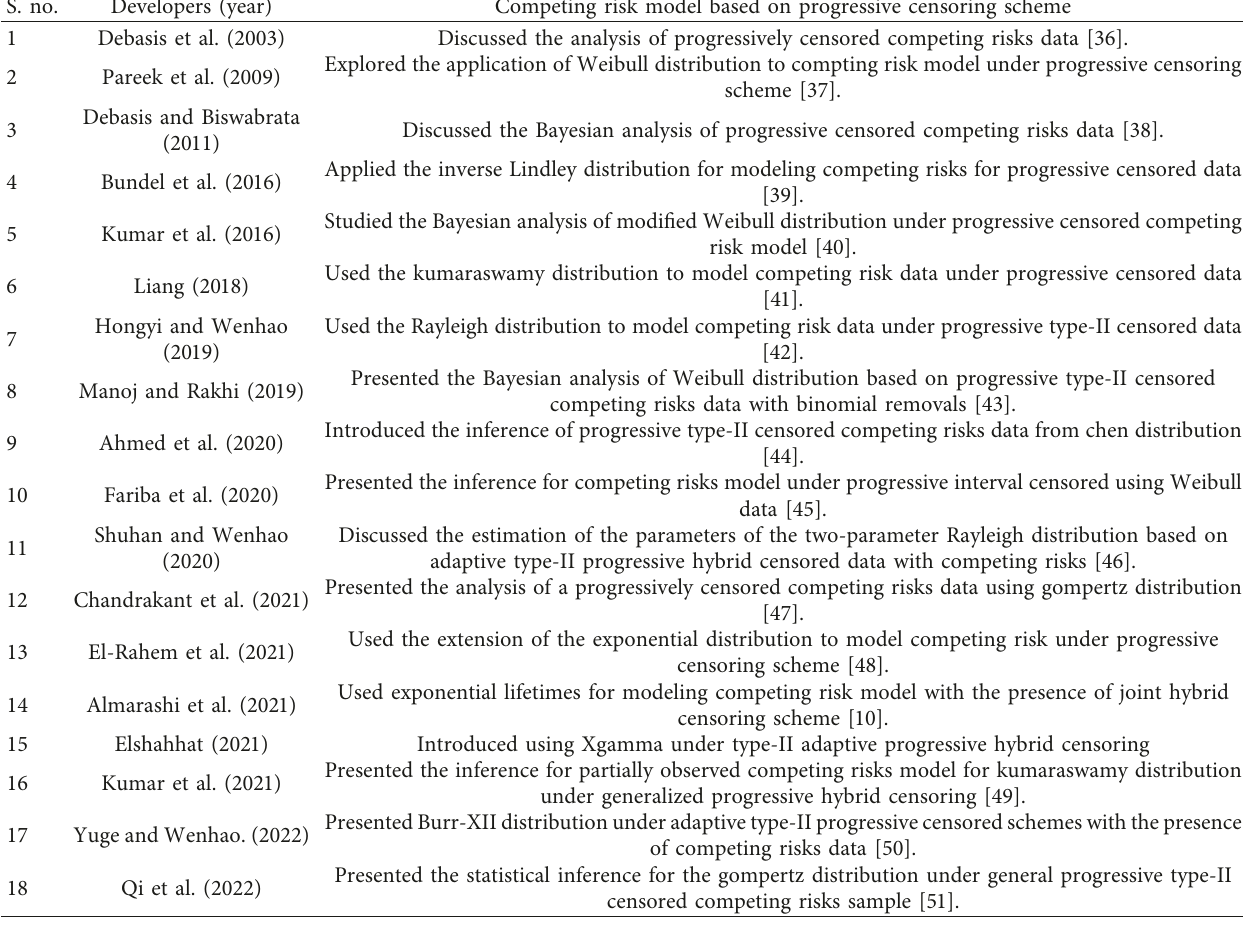
Table 1: Chronological review on competing risk models under progressive censoring scheme and their baseline distributions. S. no.